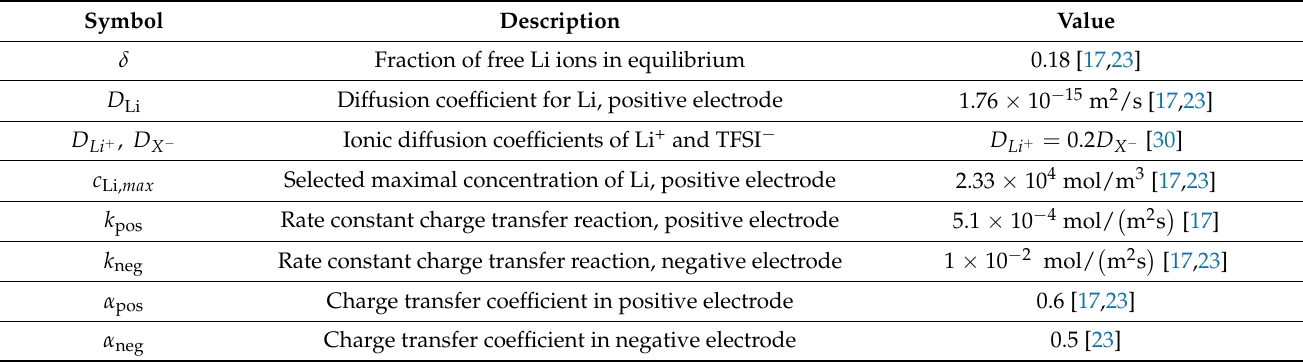
Table 2. Sets of material parameters used in the simulation.